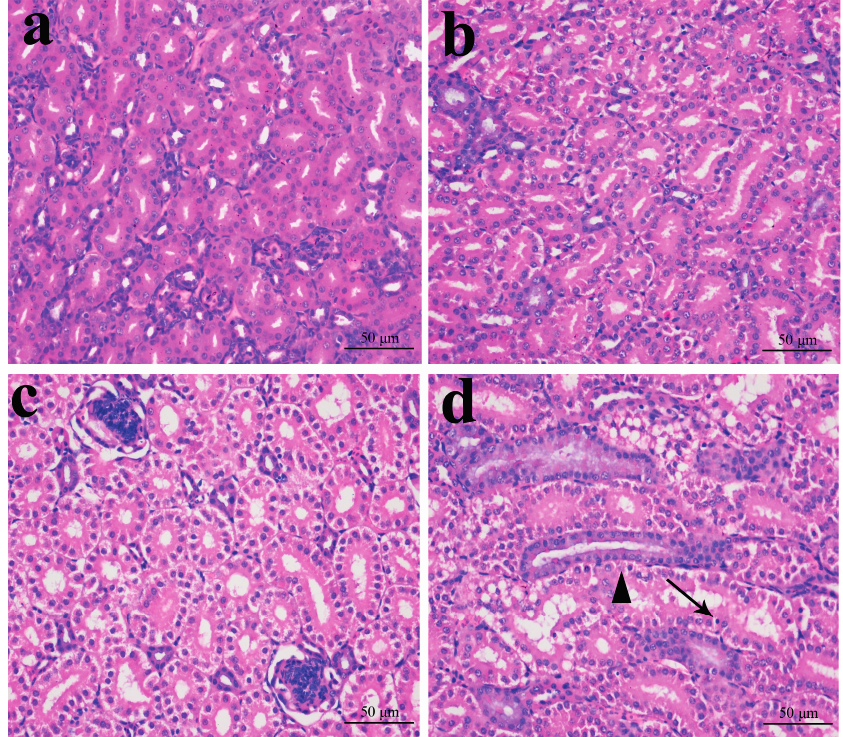
Figure 1. Histopathological changes in the kidney at 14 days of age. ( a ) Control group. No changes are observed (H·E × 400); ( b ) 300 mg/kg group. Tubular cells show slight granular degeneration (H·E × 400); ( c ) 600 mg/kg group. Tubular cells show